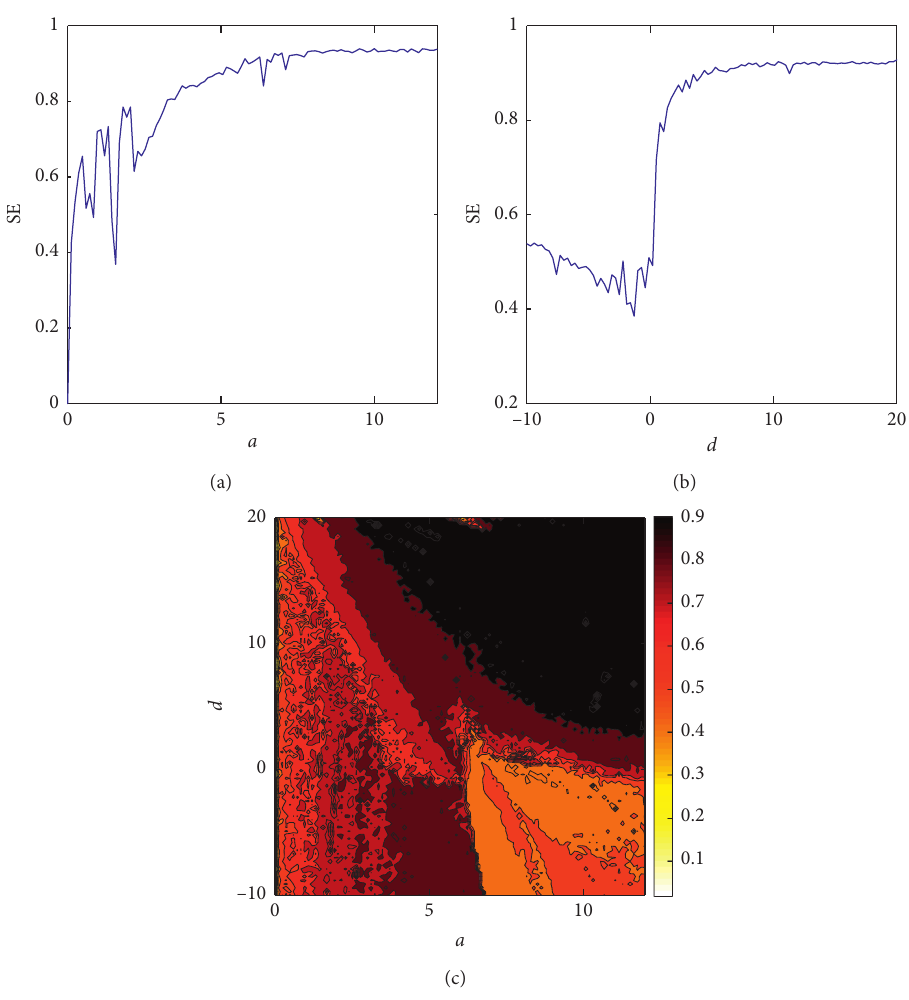
Figure 9: Spectral entropy (SE) complexity of system (4): (a) SE complexity versus a ( d � 15); (b) SE complexity versus d ( a � 10); (c) SE complexity in the a − d